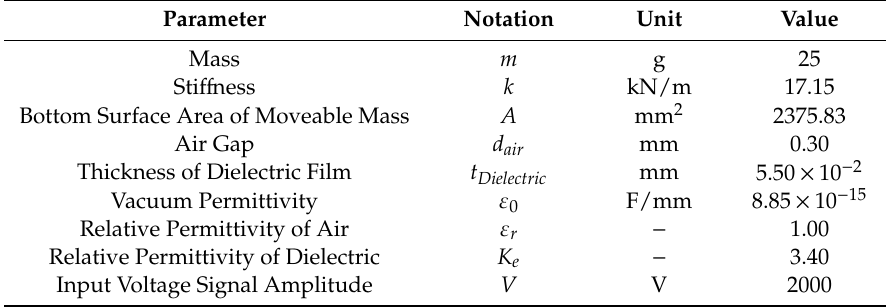
Table 1. Parameters used for the proposed ERA module’s fabrication.